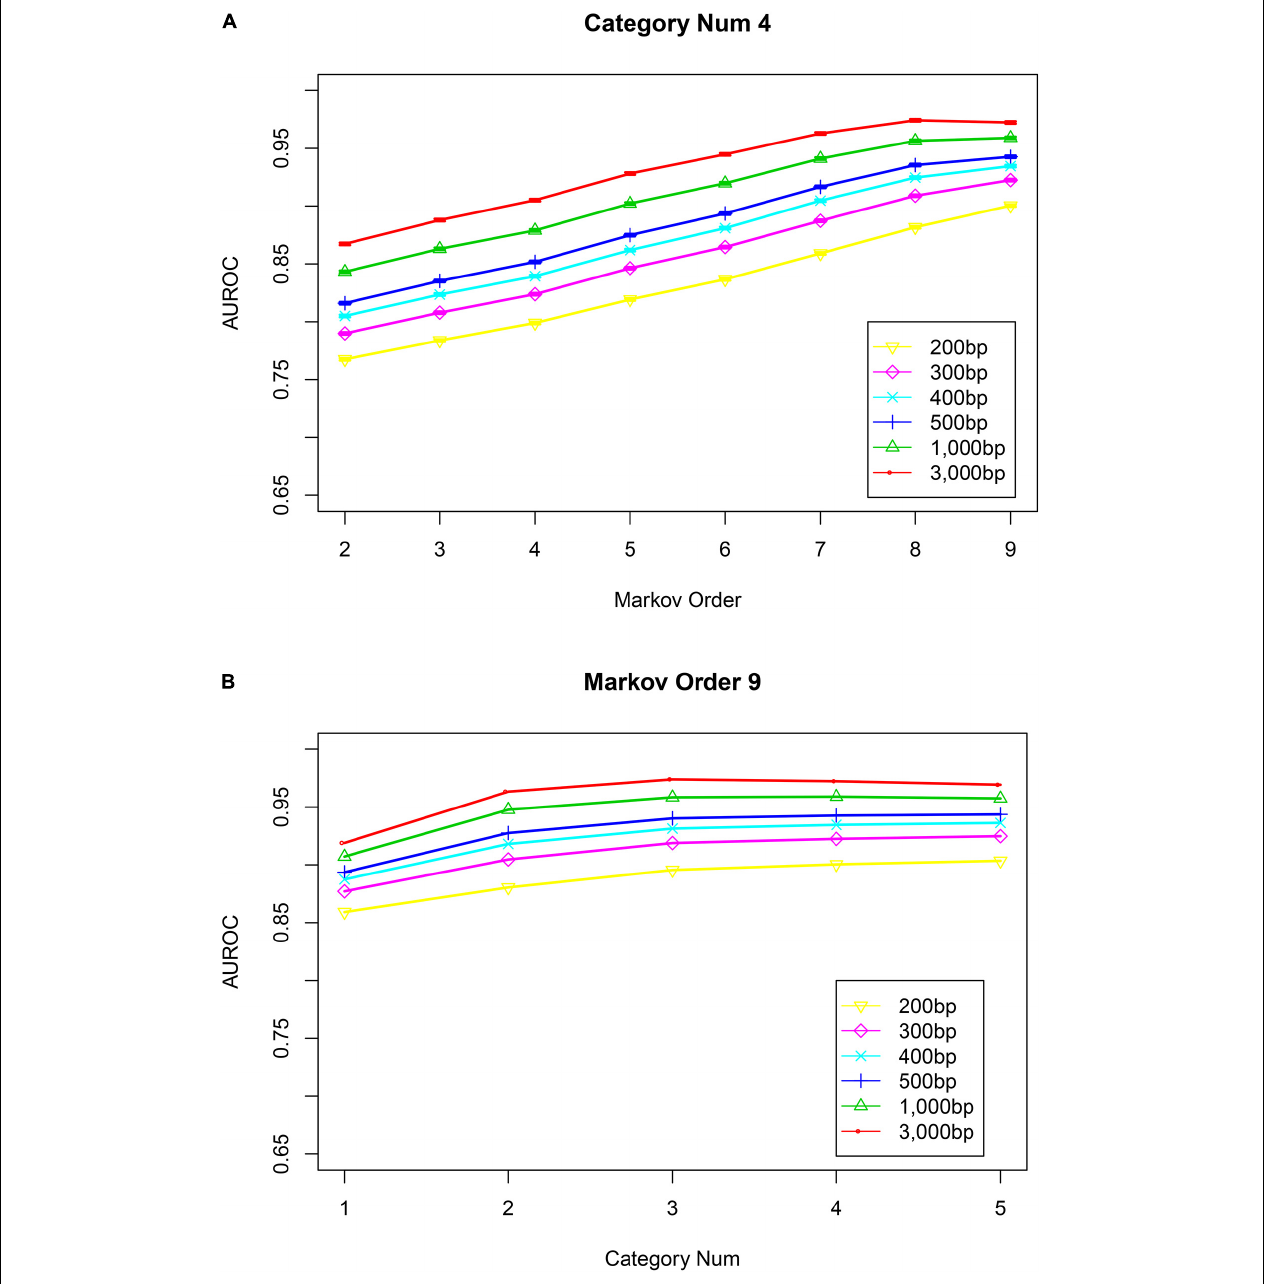
FIGURE 1 | The impact of Markov orders and numbers of cluster bins on the performance of VirMC. Error bars depict the standard error determined from 30 bootstrap samples from the validation dataset. (A) Area under the curve for receiver operator characteristic (AUROC) curves are shown when VirMC was trained using different Markov orders and tested using different contig lengths. (B) AUROC curve values for VirMC results when the training model used a Markov order of 9 and different numbers of cluster